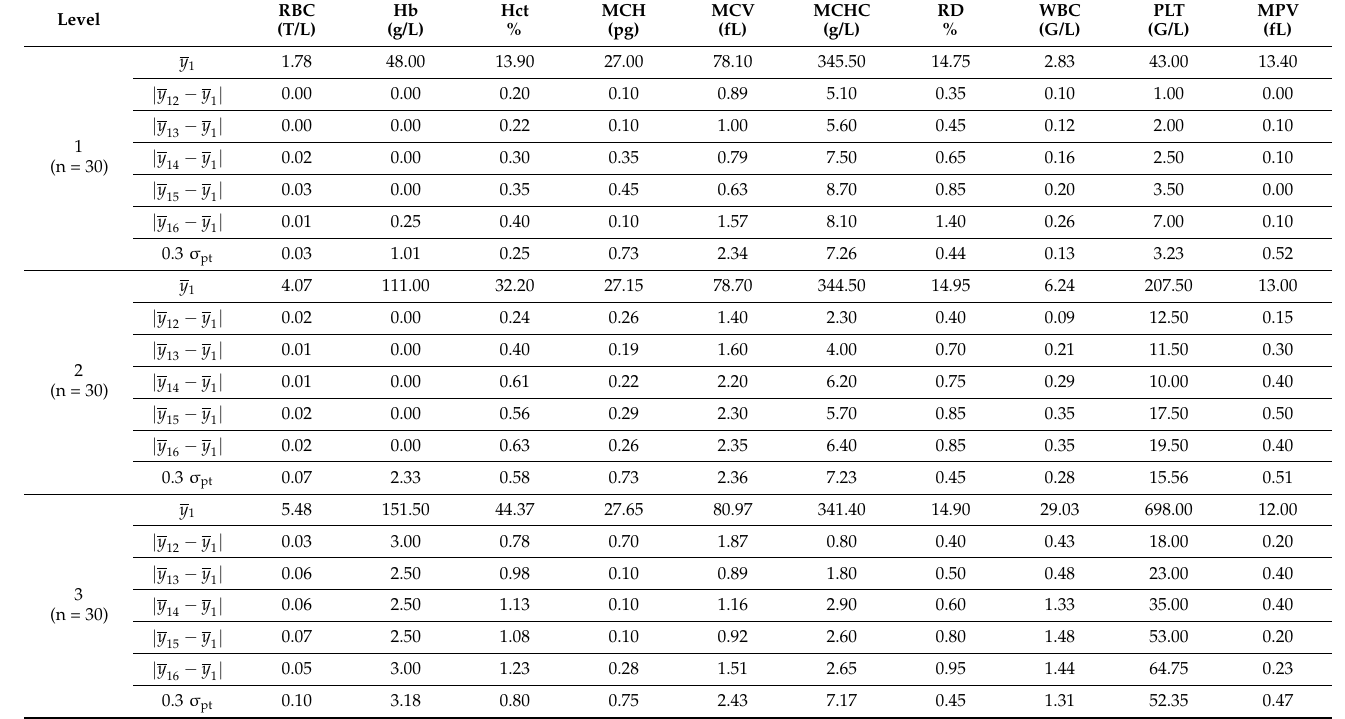
Table 2. Stability of specimens at three